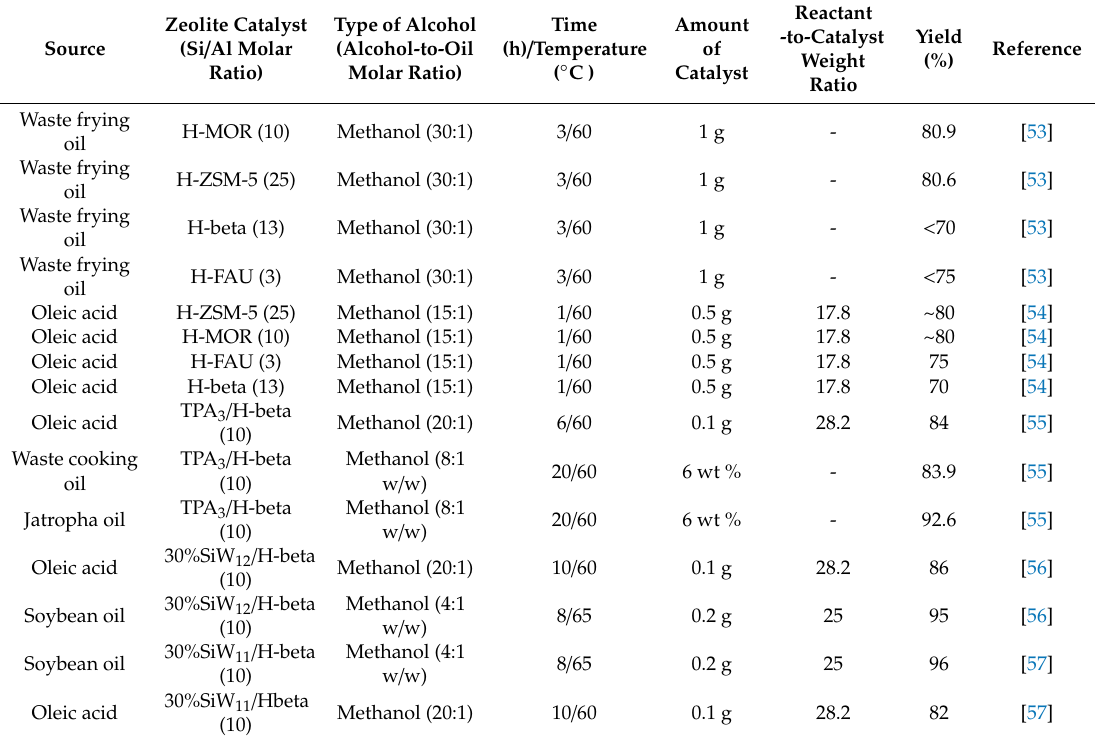
Figure 1. Schematic of biodiesel (alkyl ester) production via ( a ) esterification and ( b ) transesterification reaction. Table 1. Research reports on biodiesel production in presence of zeolite-based catalysts.